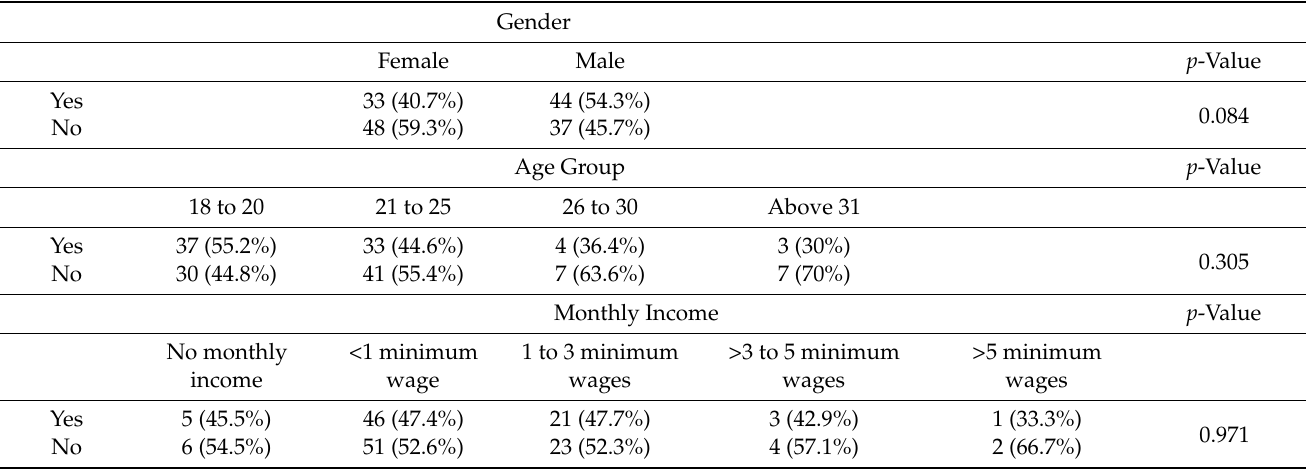
Table 1. Frequency distribution for the prevalence of adoption of health and well-being behaviors promoted by DIs, according to gender, age group, and monthly income ( n = 162). Gender Female Male p